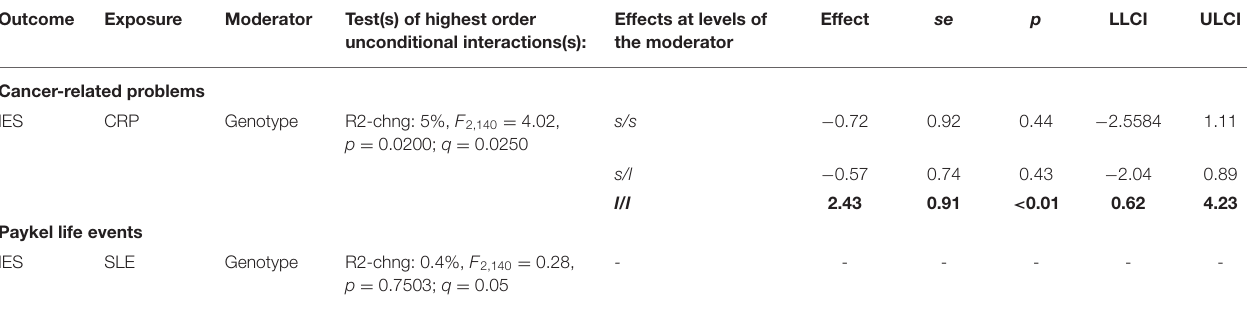
TABLE 1 | Gene-environment interactions: genotype models.